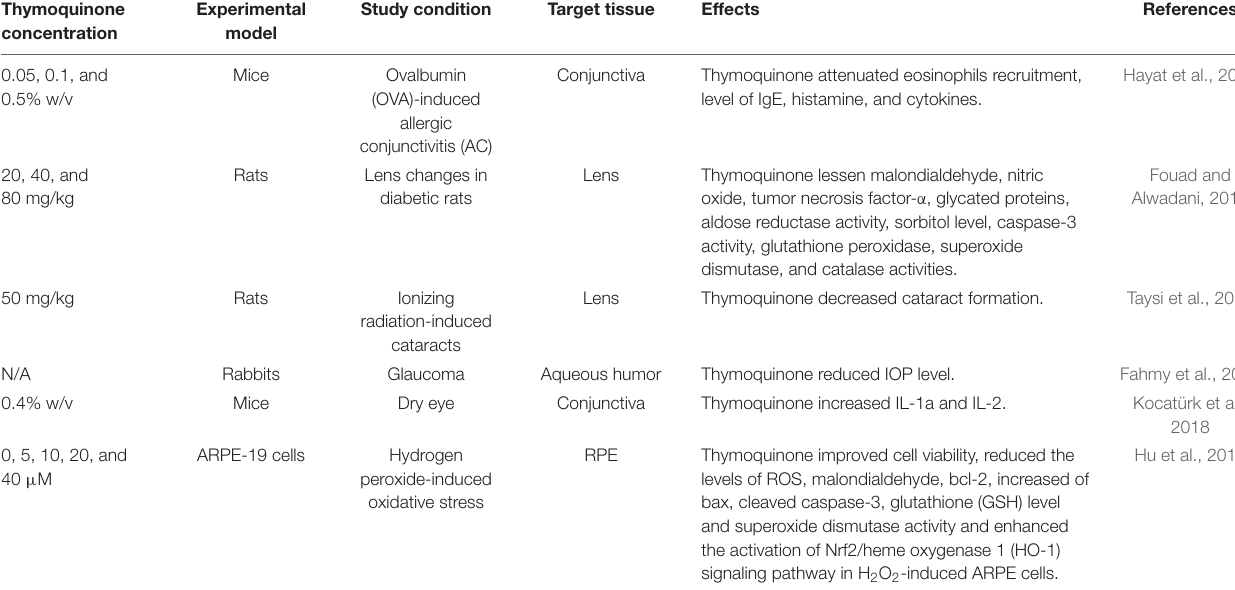
TABLE 2 | A summary of studies on thymoquinone effects in various ocular conditions. Thymoquinone